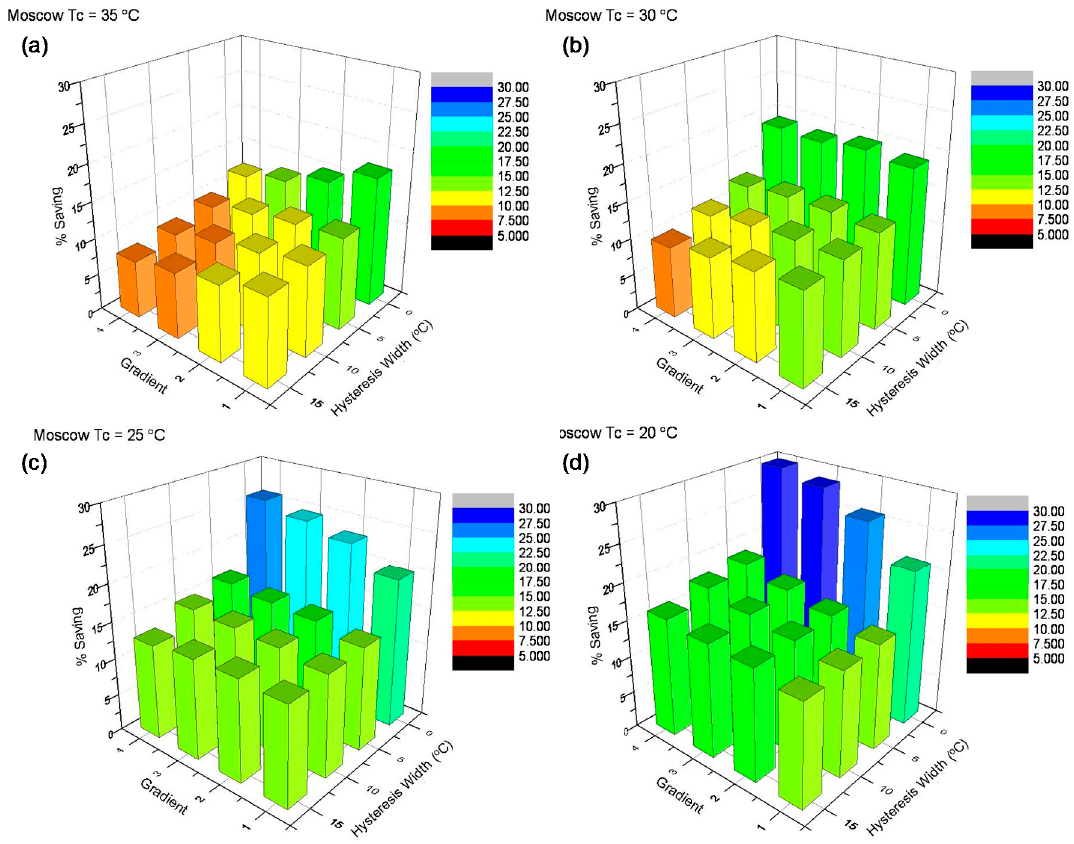
Figure 3. Energy demand reduction improvements for thermochromic glazing in Moscow with a transition temperature of ( a ) 35 °C, ( b ) 30 °C, ( c ) 25 °C and ( d ) 20 °C.